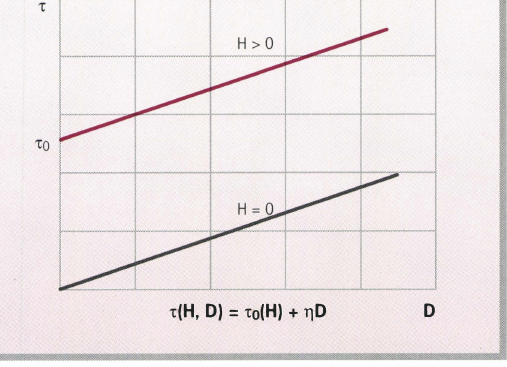
Fig. 2a: Fundamental principles of MRF-power converters: shear